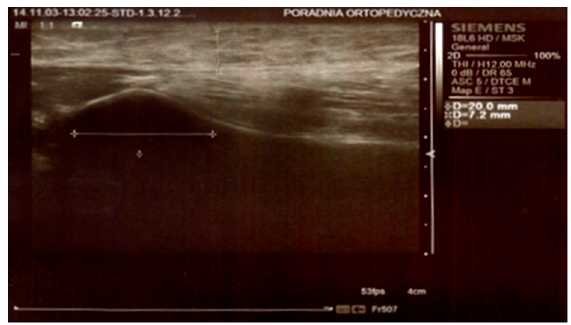
Figure 1. Ultrasound scan. Measurements at the top of the head of the fibula.